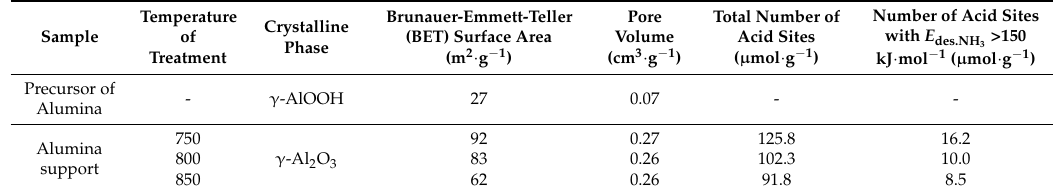
Figure 2. X ‐ ray diffraction patterns of precursor of alumina and alumina support, obtained at 800 °C.